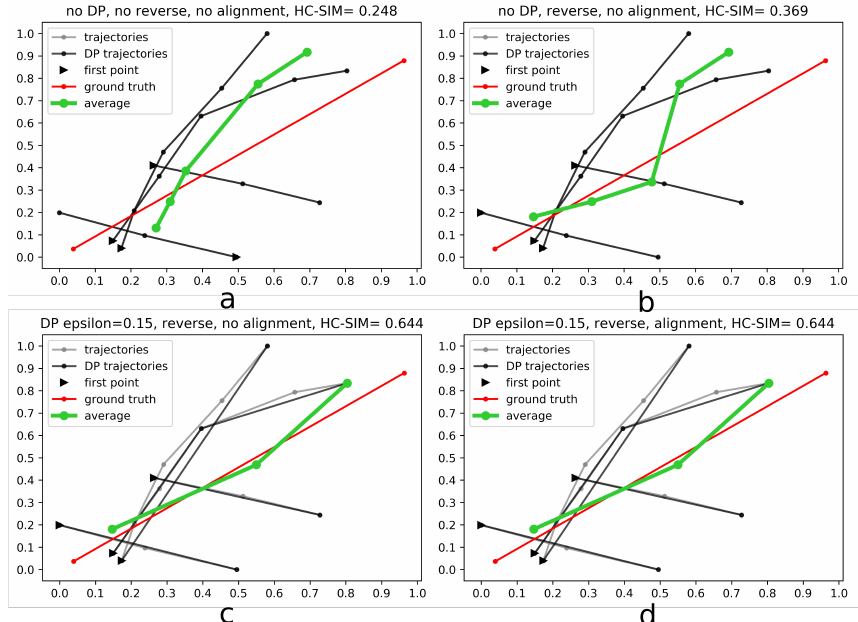
Figure A2. Algorithm applied to sample 14 with and without extensions. ( a ) No extensions just the averaging based on corresponding ids; ( b ) algorithm with reversion. The order of points in trajectory is reversed in order to group all starting points at one side; ( c ) algorithm with DP and (cid:101) set to 0.15; ( d ) algorithm including the alignment of the shorter